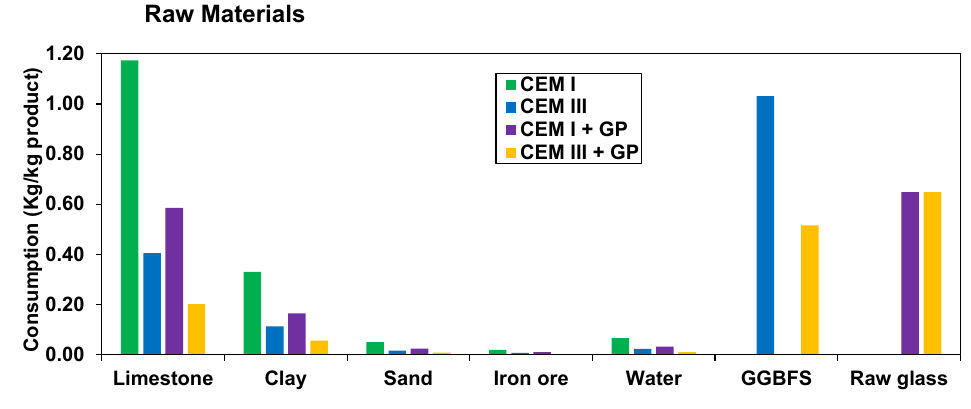
Figure 6. Raw materials’ consumption.